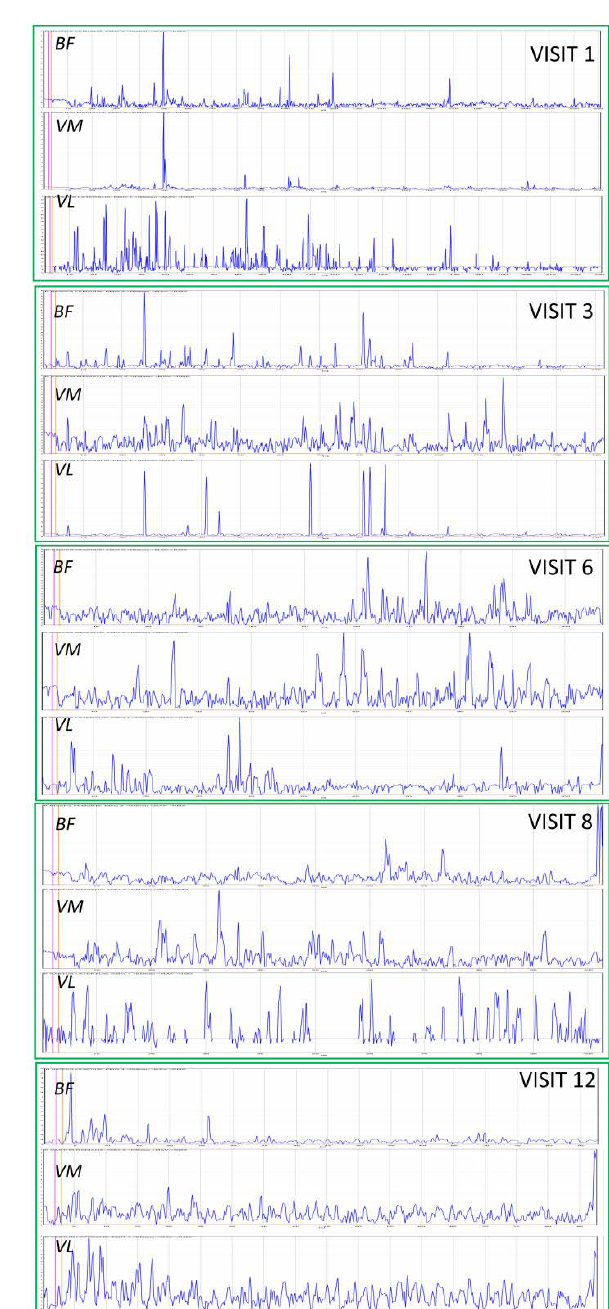
Figure 3 . Example Subject A’s EMG signals over the duration of the task for select lower-limb muscles (BF, biceps femoris; VM, vastus medialis; VL, vastus lateralis) during 5 visits spanning the initial 12 training sessions. Activation patterns tended to show more refined/consistent recruitment during later visits.